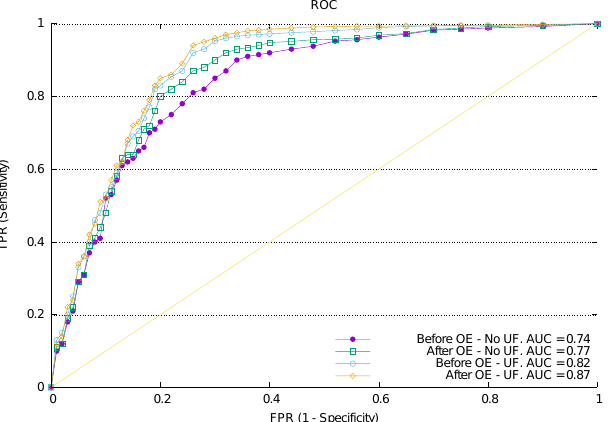
Figure 7. ROC for the different versions of the dataset: without ontology evolution and without user features. The curves are plotted for Multiclass 1 vs. all